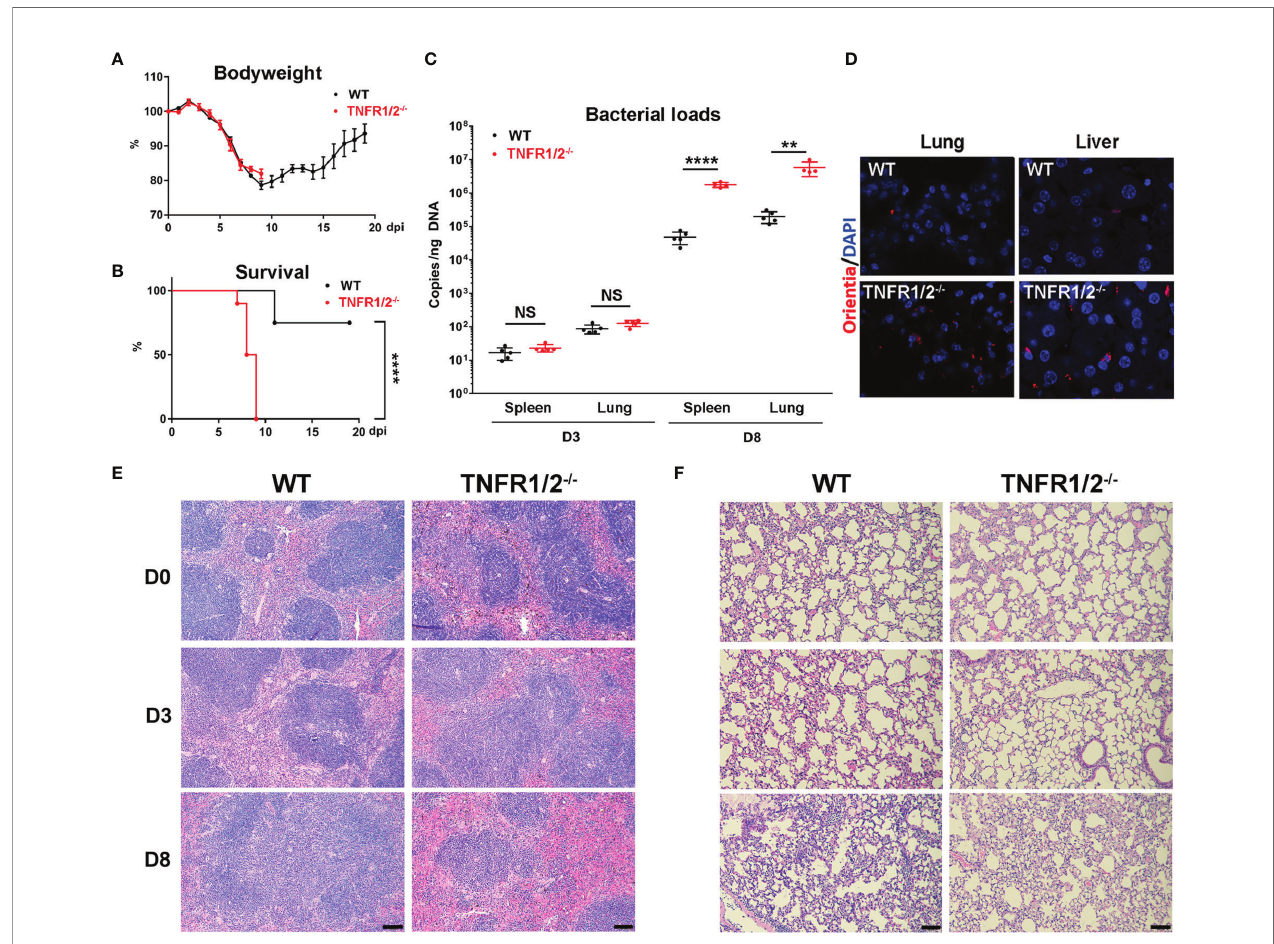
FIGURE 2 | TNFR1/2-de fi cient mice were highly susceptible to O. tsutsugamushi infection. WT B6 and TNFR1/2-di fi cient mice were infected i.v. with 6 × 10 4 FFU of bacteria. (A) Body weight and (B) survival curve (10 mice/group) were recorded daily. (C) Bacterial loads in the spleen and lungs at D3 and D8 were measured